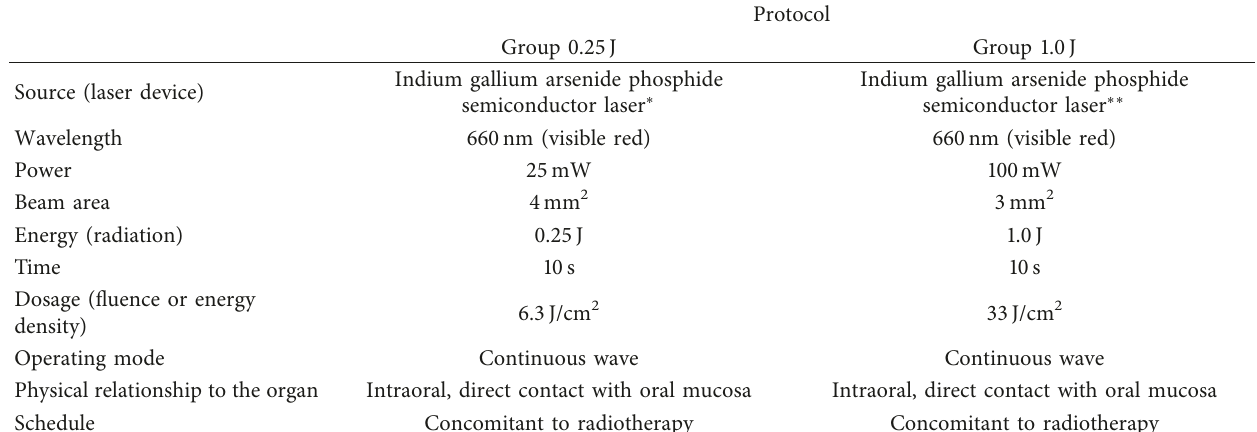
Table 1: Protocols of laser irradiation (adapted from Zecha et al. [11]).